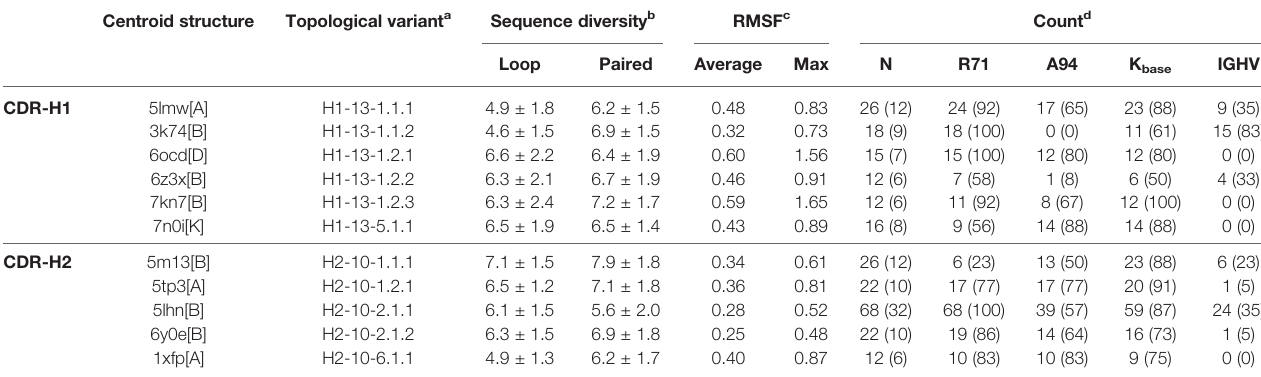
TABLE 1 | Properties of CDR-H1 and CDR-H2 clusters for single-domain antibodies. Centroid structure Topological variant